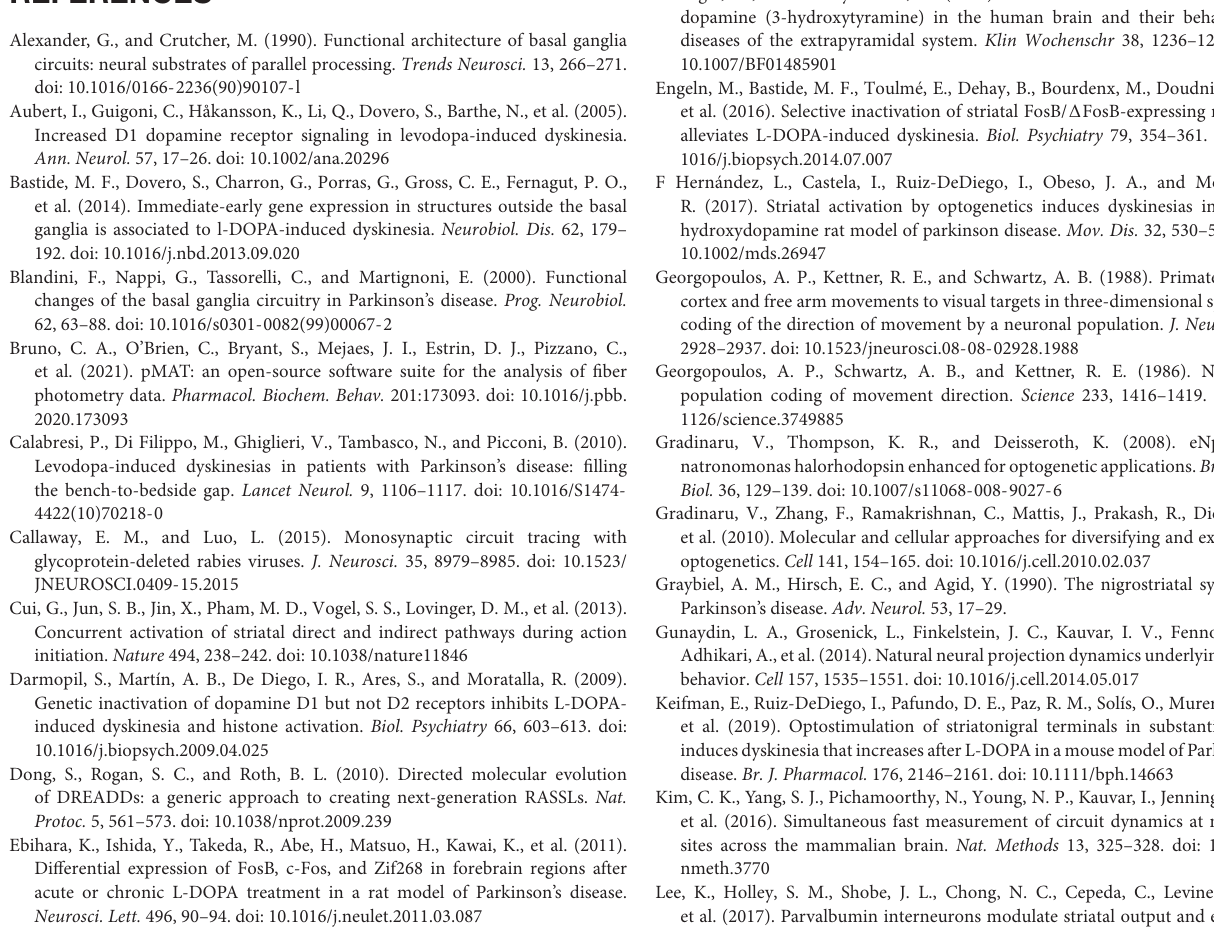
Supplementary Figure 1 | Representative histology figures ( A–C ; scale bar = 50 µ m) of c-Fos immunoreactivity in the striatal brain section of D 1 -Cre-mCherry LID rats after saline administration. Str, striatum. Supplementary Figure 2 | Representative histology figures ( A–C ; scale bar = 50 µ m) and Quantification ( D ; green: D 1 + cell number, red: D 1 -Cre-mCherry + cell number, yellow: percentage of D 1 + neurons positive for D 1 -Cre-mCherry; n = 8) of D 1 immunoreactivity in the striatal brain sections of D 1 -Cre rats after intra-striatal injection of AAV5-DIO-mCherry. Supplementary Video 1 | A replay of simultaneous GCaMP 6m -based fiber photometry signal (raw data) from striatal D 1 + neurons and real-time behavioral video of a D1-Cre rat with levodopa-induced dyskinesia (LID). D 1 -Cre LID rats were placed individually in the center of the box at 30–80 min after levodopa administration. The animals received an intra-striatal infusion of AAV5-EF1a-DIO-GCaMP6m-hGH-pA at 4 weeks before the test. Supplementary Video 2 | A video showing suppression of dyskinetic movements in a D1-Cre rat with levodopa-induced dyskinesia (LID) following eNpHR3.0-based optogenetic inhibition of striatal D 1 + neurons. D1-Cre LID rats were placed individually in the center of the box at 50–70 min following levodopa administration, and their dyskinetic behavior was tracked for 9 min in optogenetic inhibition tests with 3 min of light inhibition (589 nm, 10.5–s ON/2–s OFF